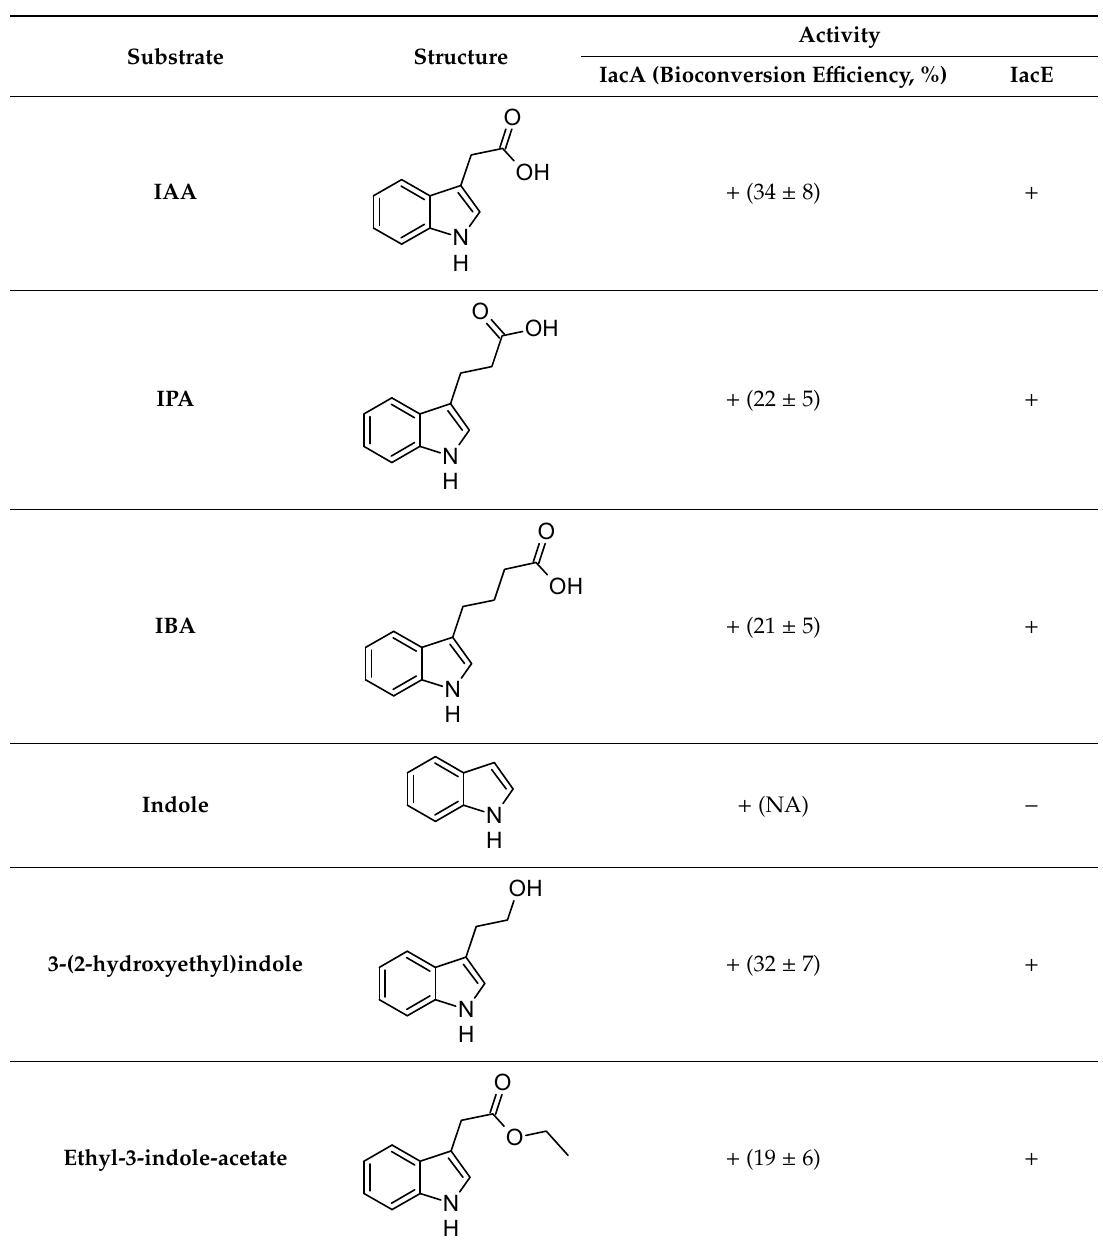
Table 1 . Substrate scope of IacA and IacE. Products of the IacA-catalyzed reaction—homologs of Ox- IAA, products of IacE-catalyzed reaction—homologs of DOAA. “+” indicates successful conversion, “ − “ indicates no conversion, NA—not analyzed. Bioconversion efficiency of IacA is presented as mean ± SD.